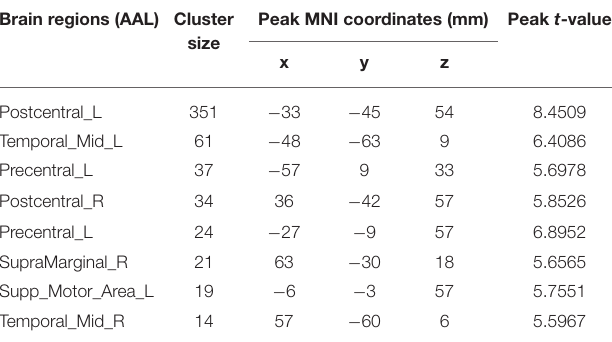
TABLE 4 | Brain regions with significant differences based on a conjunction analysis of SO and SS (voxel-level, FDR-corrected p < 0.001, cluster size > 10